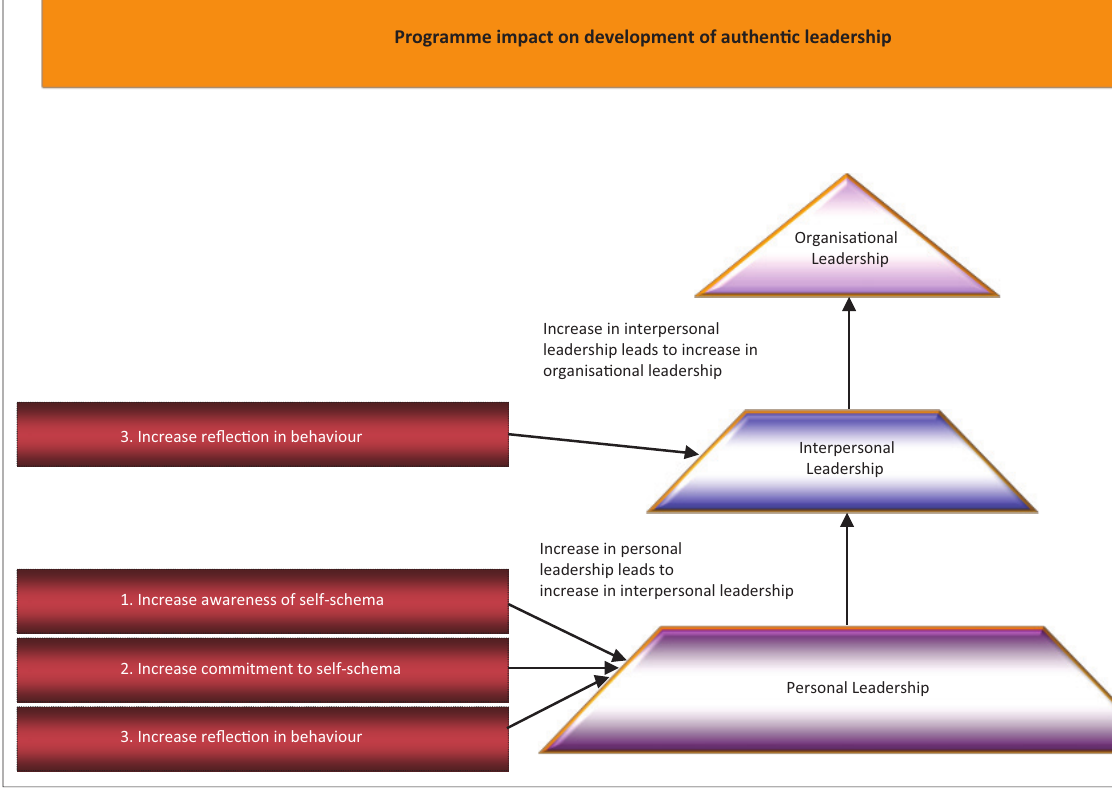
FIGURE 2: Programme impact on development of authentic